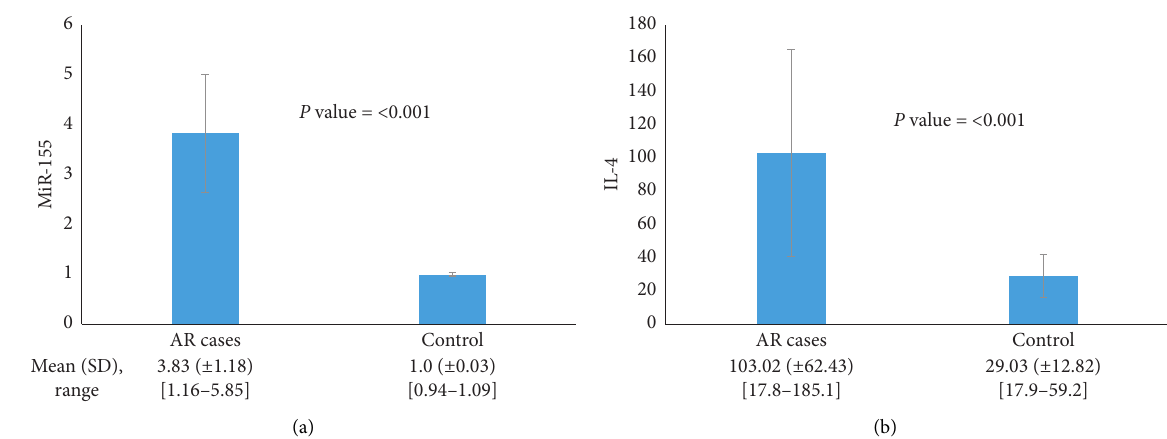
Figure 1: Comparison between the studied groups regarding (a) miR-155 and (b) IL-4 serum levels. AR: allergic rhinitis and SD: standard deviation.